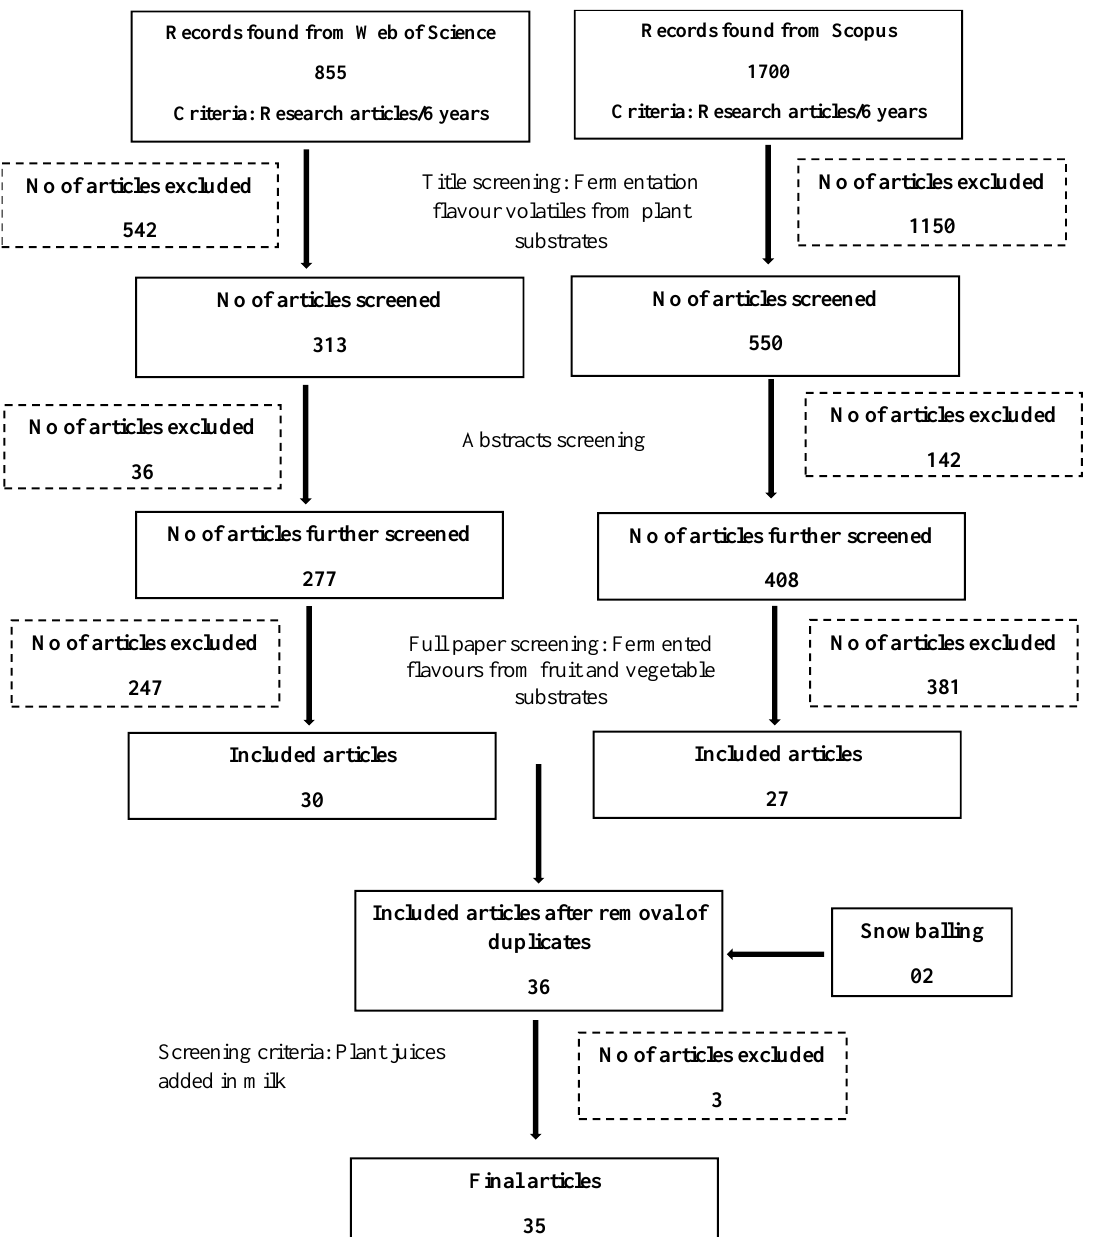
Figure 1. PRISMA flowchart of the review on flavour volatiles of fermented vegetable and fruit substrates.